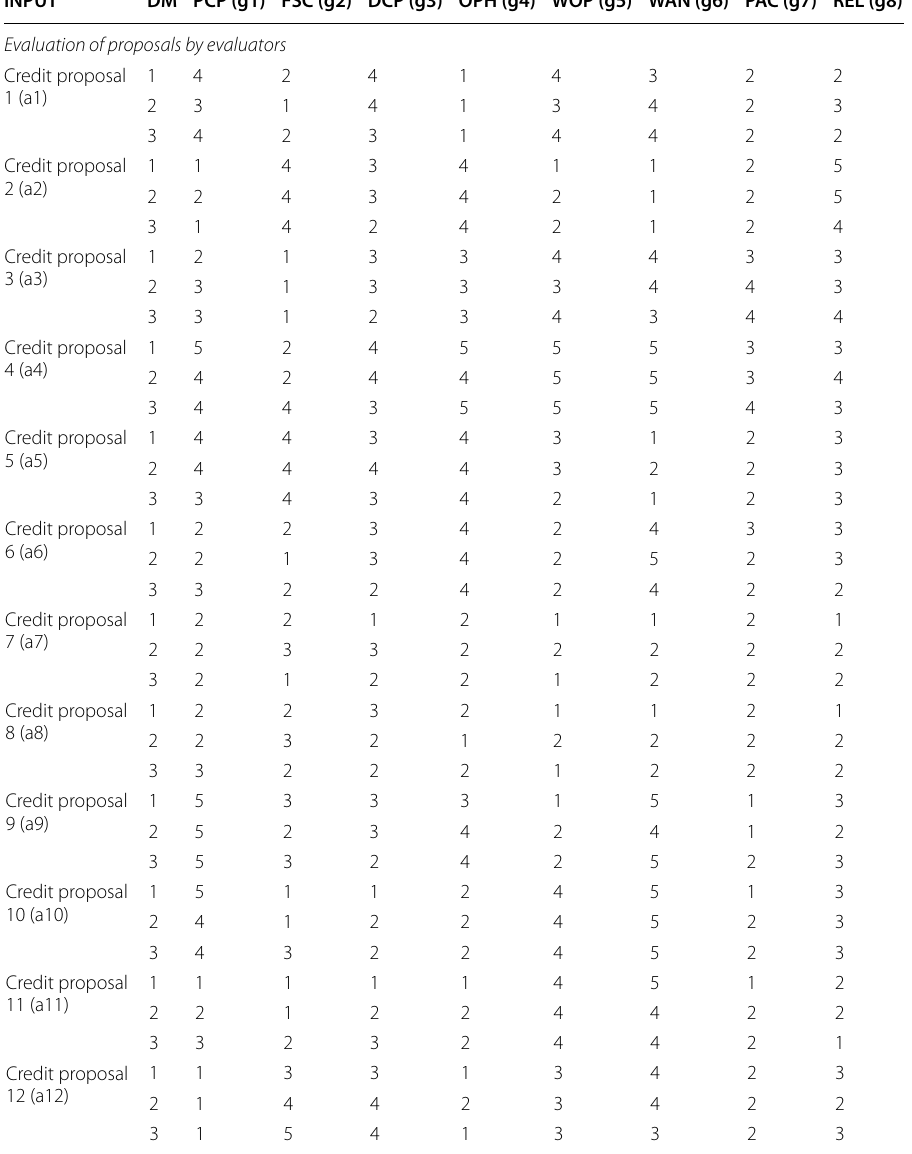
Key for criteria: FSC financial score, DCP debt capacity, PCP payment capacity, WAN wealth analysis, OPH operations history, WOP warranty in operation, PAC professional activity, REL relationship